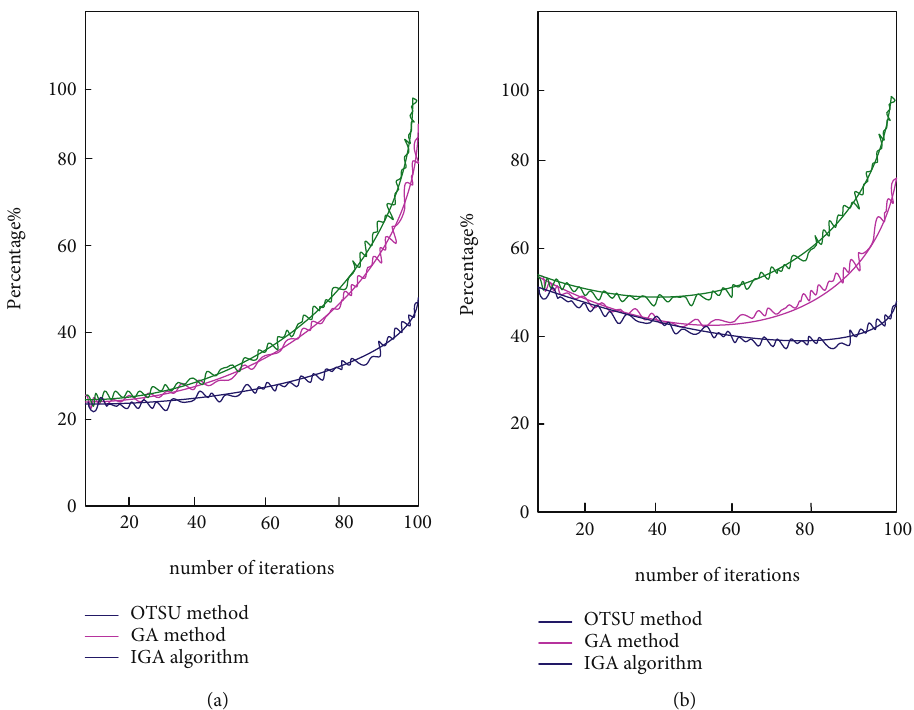
Figure 7: Segmentation e ff ect of the three algorithms in the case of di ff erent image clarity. (a) The segmentation e ff ect of the three algorithms when the image is clear. (b) The segmentation e ff ect of the three algorithms when the image is blurred. Table 3: Classi fi cation errors after segmentation of medical images. Images